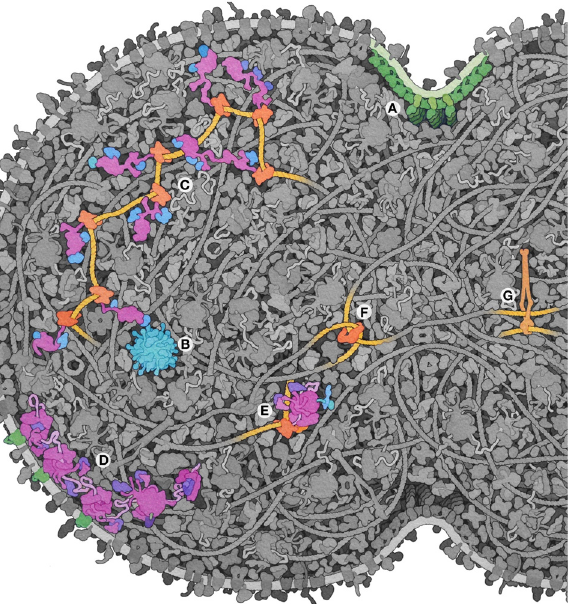
Figure 2: Narratives depicted in the illustration. (A) Proteins involved in cellular scission. (B) Pyruvate dehydrogenase complex, the largest assembly in the proteome. (C) Transcription of a ribosomal RNA operon. (D) Initiation and translation of membrane proteins by membrane-bound ribosomes. (E) An expressome with co- transcriptional translation. Two proteins managing the topology of chromosomes: (F) Topoisomerase and (G) Structural maintenance of chromosomes